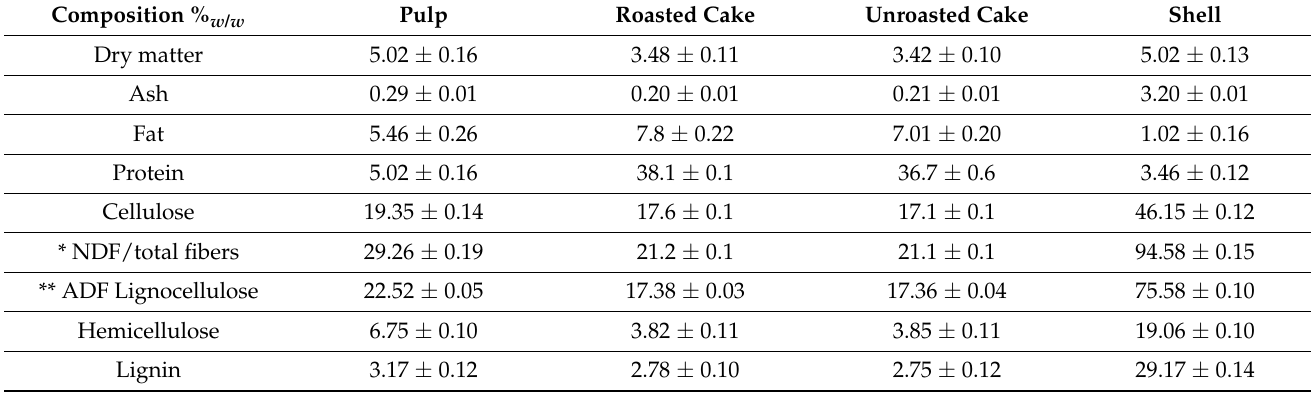
Table 1. Content of main chemical constituents of argan byproducts (pulp, cake, and shell).